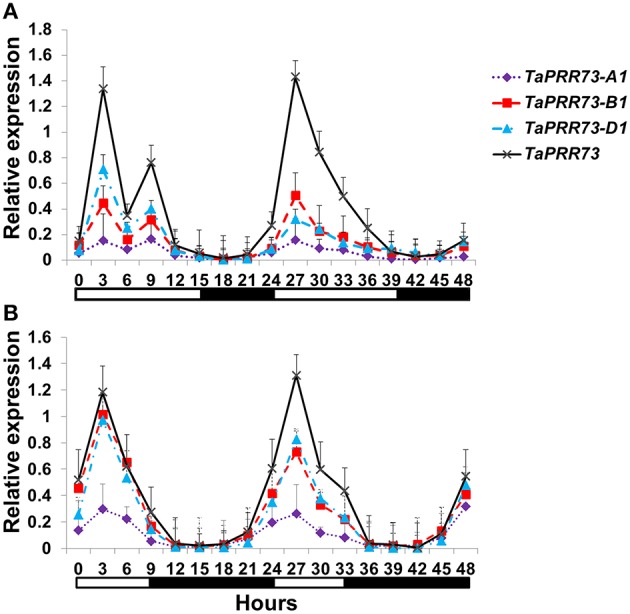
Relative circadian expression of TaPRR73 in cv. Hussar under LD and SD conditions. (A)
TaPRR73, TaPRR73-A1, TaPRR73-B1, and TaPRR73-D1 in LDs. (B)
TaPRR73, TaPRR73-A1, TaPRR73-B1, and TaPRR73-D1 in SDs. The expression level of TaPRR73 reached a peak 3 h after dawn. The contrasting environments were 15 h light/9 h darkness and 9 h light/15 h darkness. Four biologically independent replications were performed for each sample. White boxes below the graphs indicate light periods; dark boxes indicate darkness. The data were normalized by GADPH.